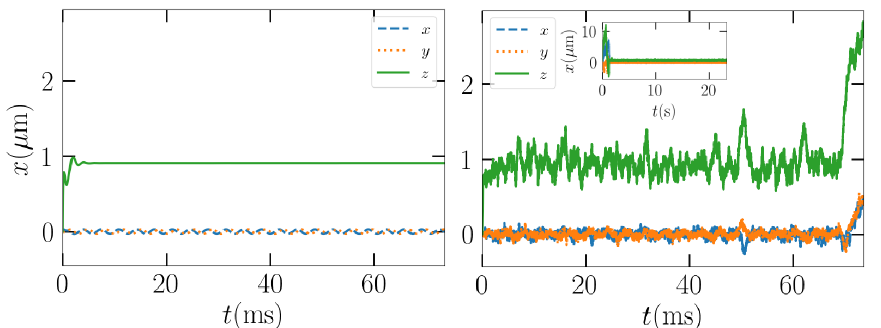
Fig 12. Left: The path of the 0.2 μ m Gaussian ellipsoid example particle without Brownian motion. Right: The same with Brownian motion enabled with a zoom-out to of the whole simulation.